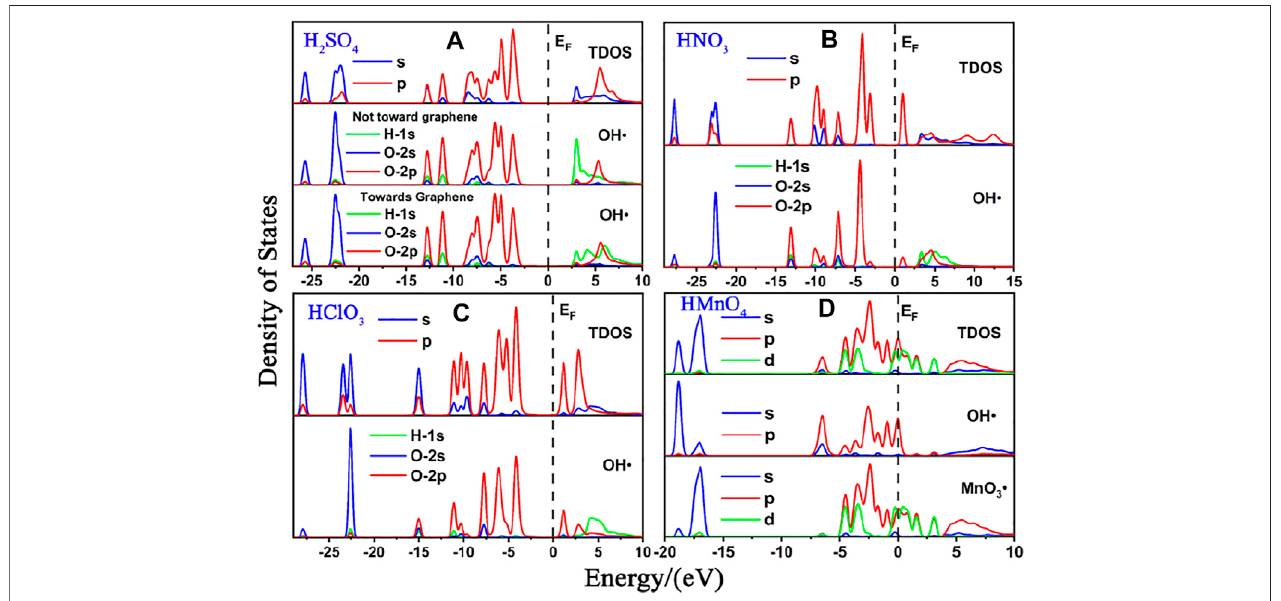
FIGURE2| DOSofsingle-componentacidmoleculesreacting withtheStone-Walesdefectgraphene intheabsenceofwater. (A) , (B) , (C) ,and (D) aretheDOSof H 2 SO 4 , HNO 3 , HClO 3 and HMnO 4 , respectively. In each diagram, the top represents the TDOS, and the bottom represents the LDOS of OH (cid:129) the LDOS of MnO 3 at the bottom of (D) .